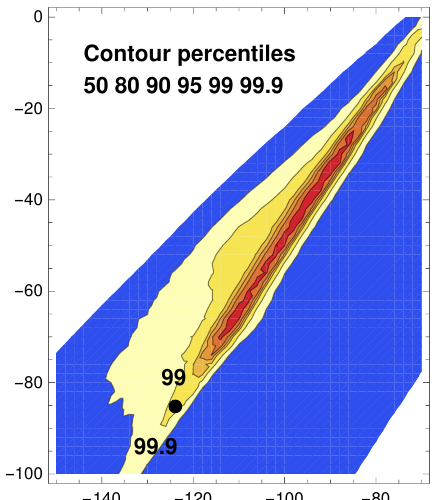
Figure 10. Contour plot of the log likelihood with detectors at z 0 = 1m based on considering only the data acquired in the eighth 20min period with x , y positions as in Fig. 8. These results are rep- resentative of how well the plume parameters can be determined with a traditional measurement. Although localization is good in one dimension, there is an uncertainty of roughly 100m in the other. The estimated leak location from Fig. 8 is shown with a dot. The re- sult is in marginal disagreement with these measurements, lying be- tween the 95th and 99th percentile contours of given by the χ 2 tribution divided by